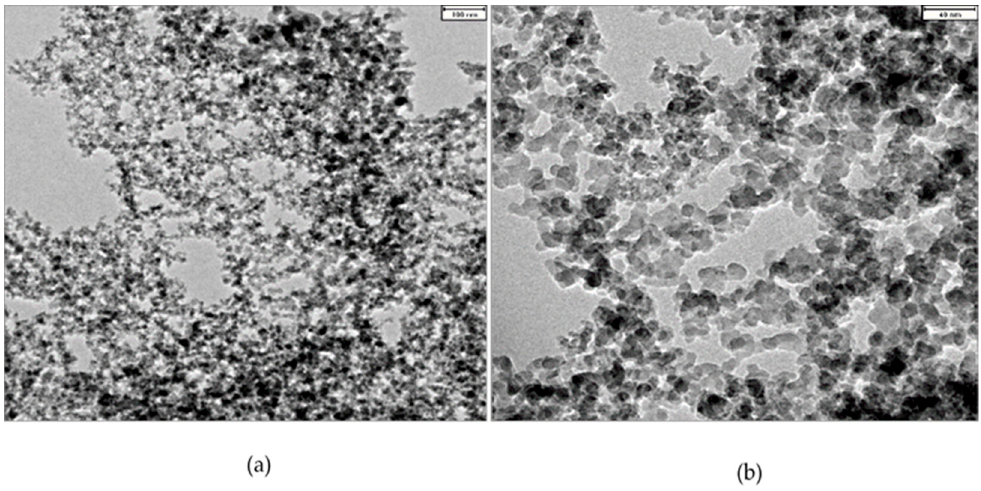
Figure 2. TEM micrographs of silica nanopowder at two magnifications. Silica particles